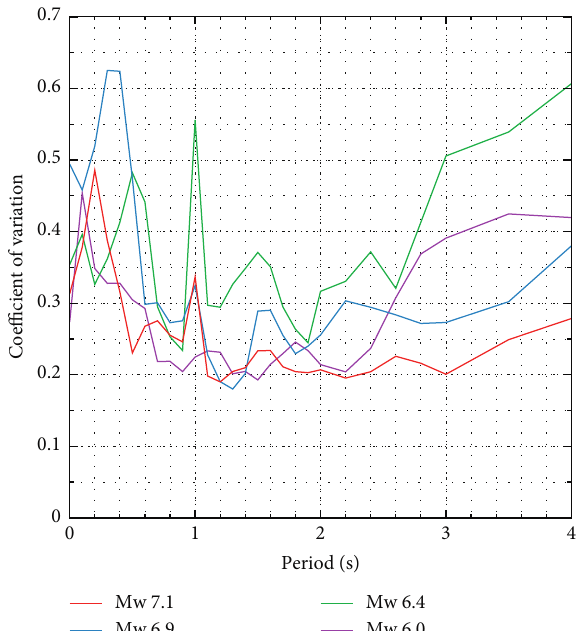
Figure 8: Coefficients of variation for the spectral accelerations as a function of the earthquake magnitude.